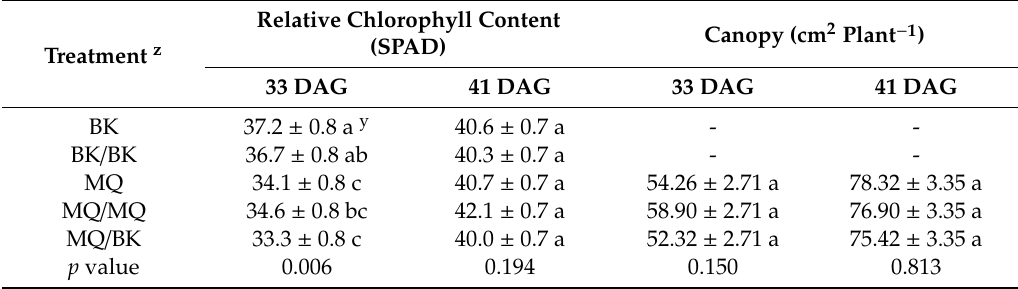
Table 1. Relative chlorophyll content and canopy size of grafted, self-grafted, and non-grafted pac choi and daikon radish plants at 33 d after grafting (DAG) and 41 DAG in the 2019 experiment. Treatment z